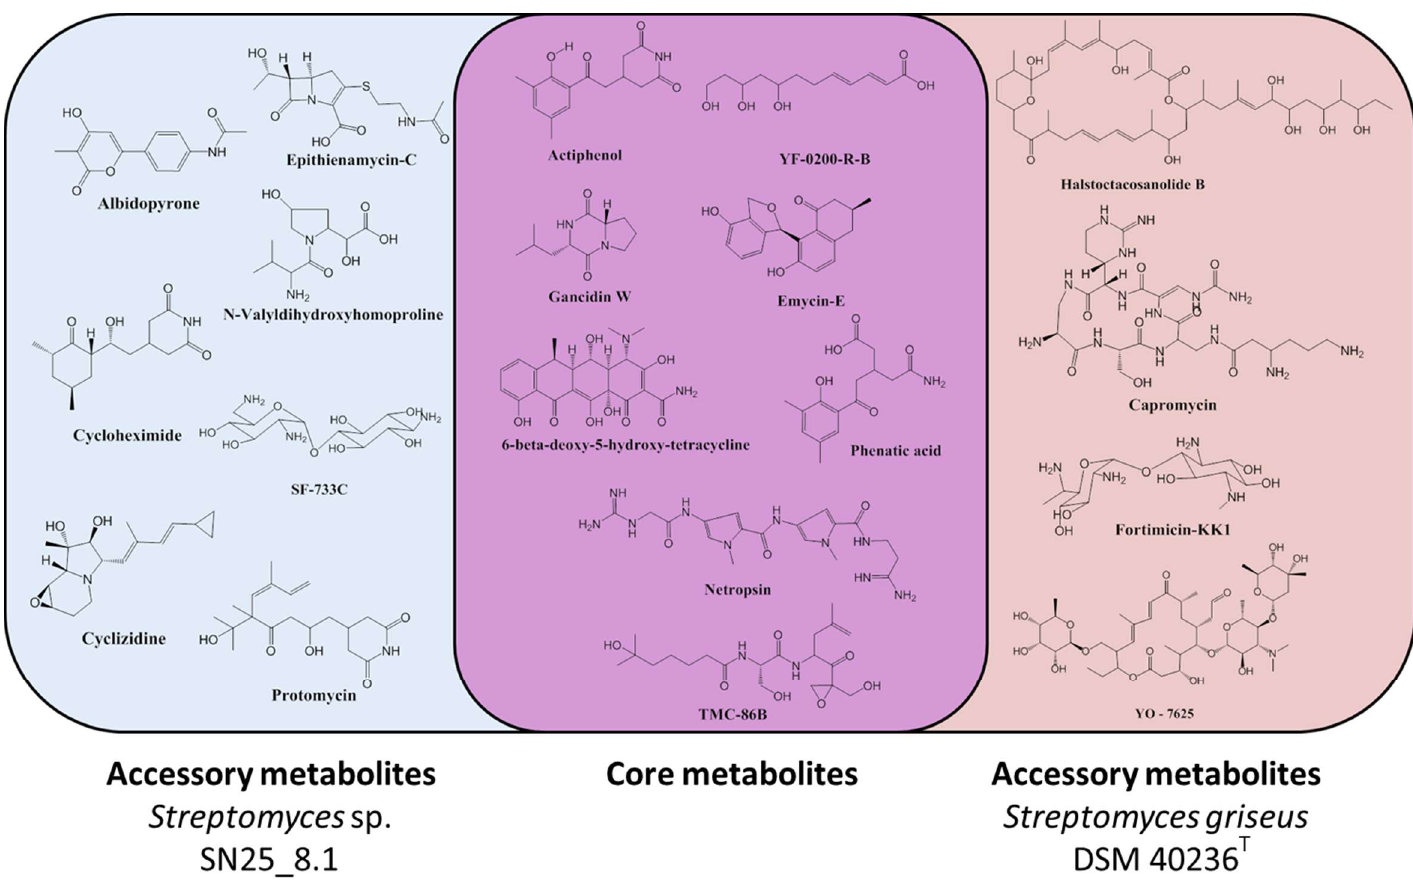
Figure 4. Chemical diversity of the studied Streptomyces representatives. Core metabolites: Metabolites shared by both strains. Accessory metabolites: Unique metabolites for each of the studied strains.